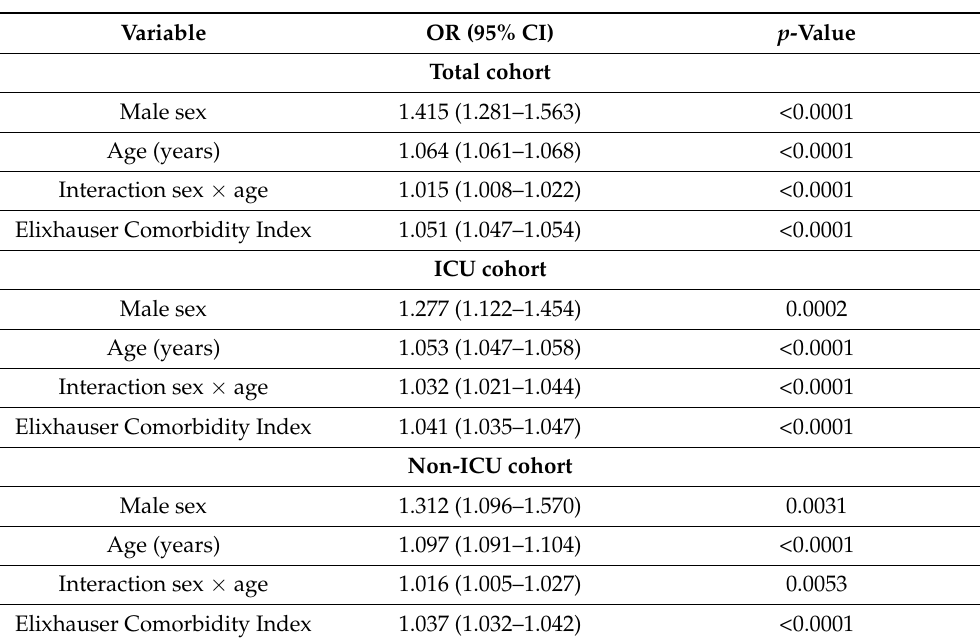
Table 5. Results of Multivariable Analysis of In-Hospital